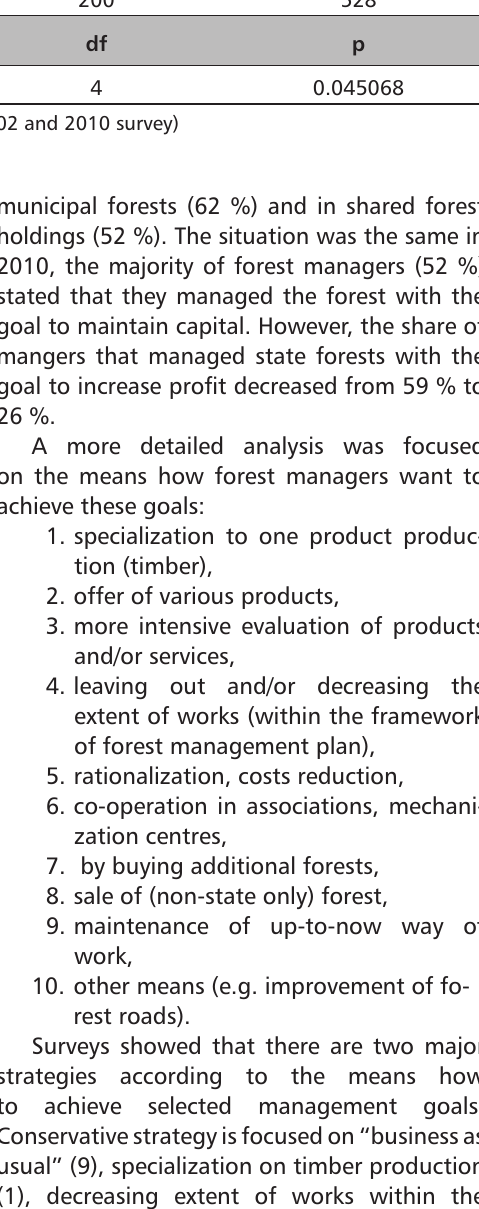
* presented data represent results from joined dataset (2002 and 2010